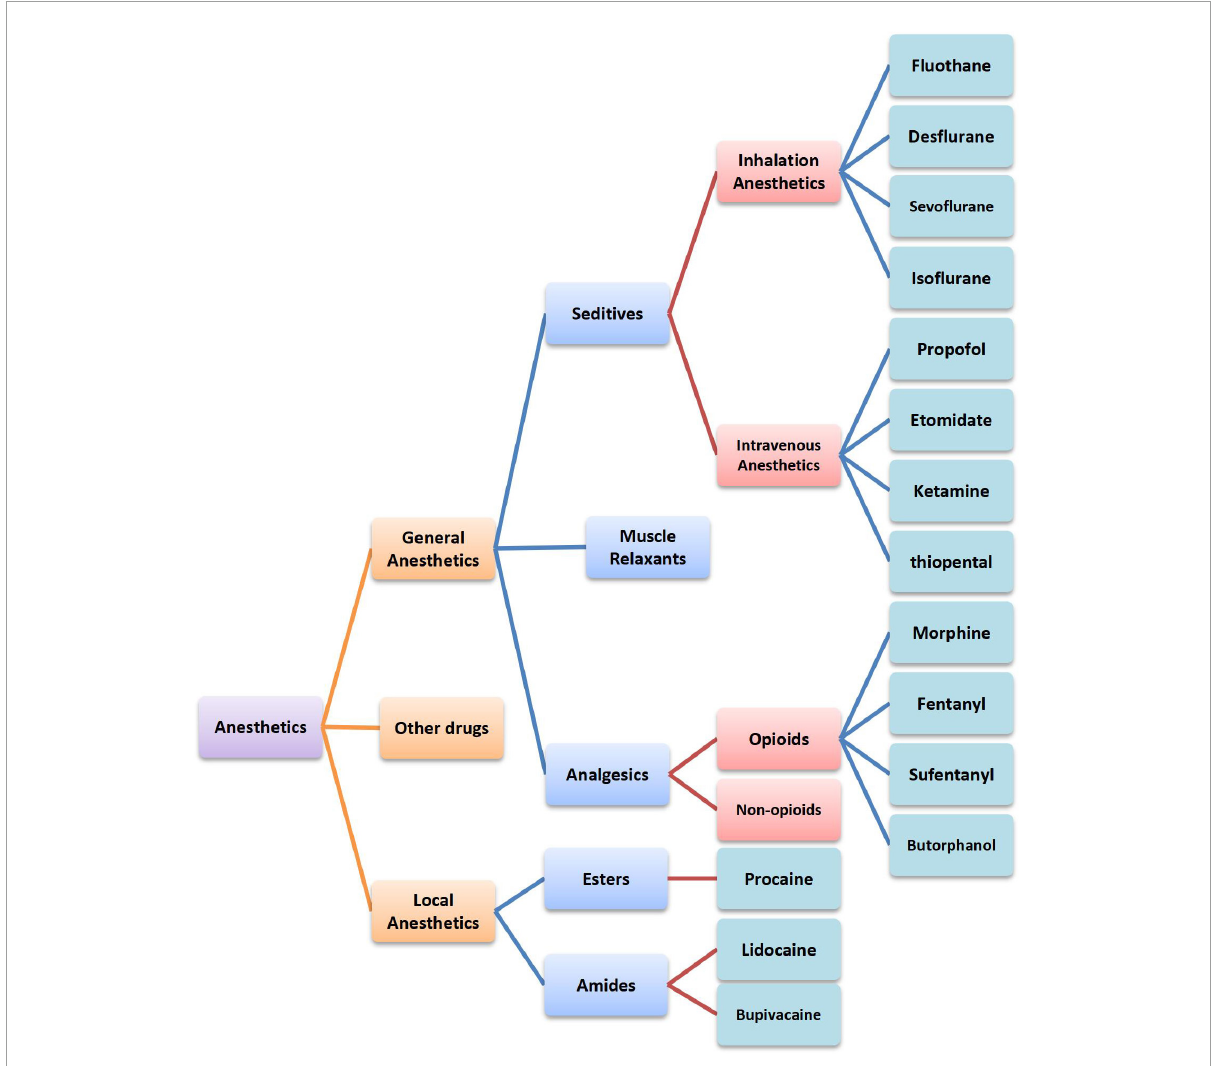
FIGURE1 Classification of anesthetics commonly used in clinical